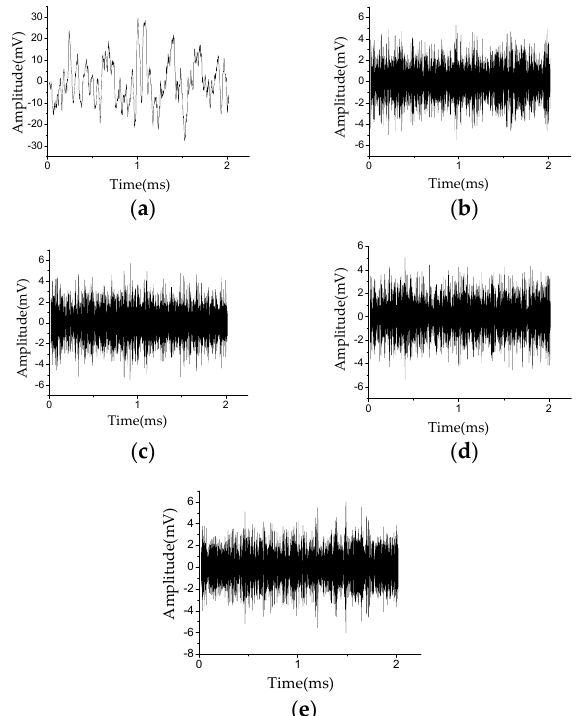
Figure 8. Waveforms of Lamb wave damage signal D(t): ( a ) pure damage signal; ( b ) damage signal with white noise; ( c ) damage signal with environment noise; ( d ) damage signal with mixed noise.